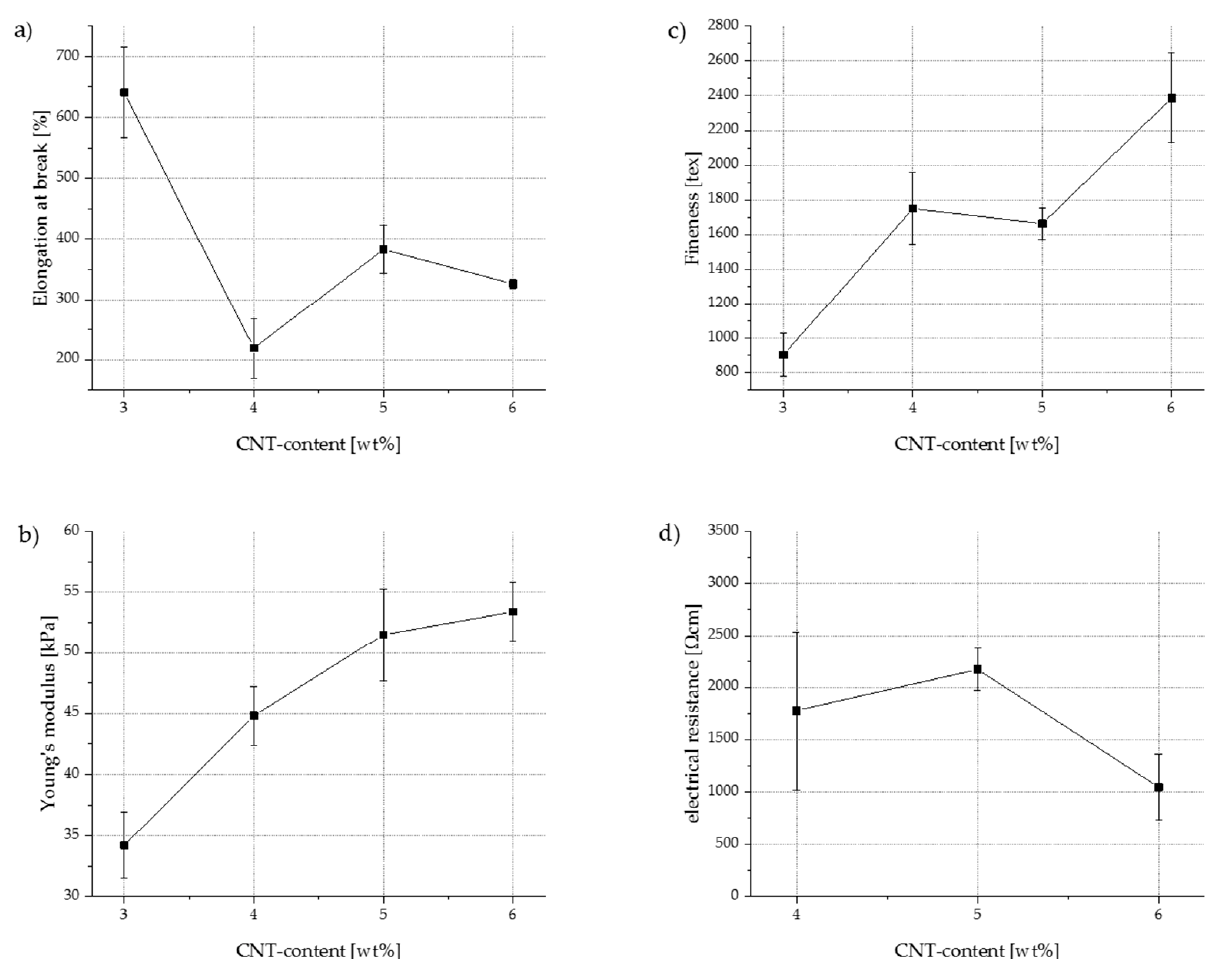
Figure 6. Mechanical and electrical properties of TPU–CNT multifilament yarns processed at a spinning speed of 15 m/min: ( a ) elongation at break as functions of CNT content in TPU; ( b ) Young’s modulus as functions of CNT content in TPU; ( c ) fineness as functions of CNT content in TPU; ( d ) electrical resistance as functions of CNT content in TPU.